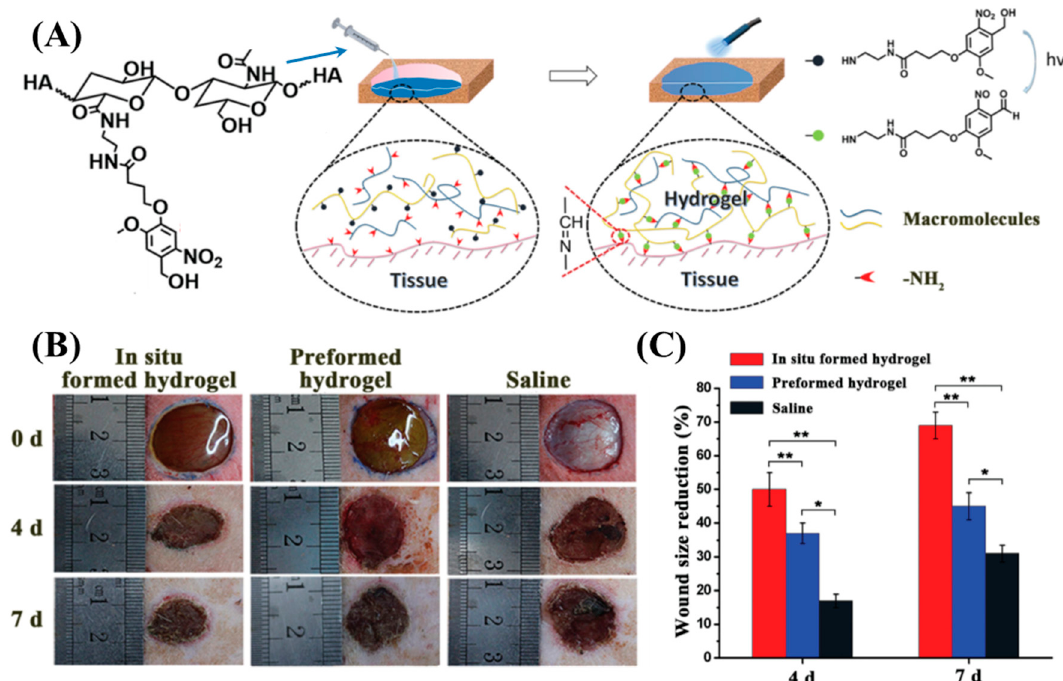
Figure 5. ( A ) Schematic representation of the phototriggered-iminecrosslinking (PIC) and adhesion mechanism of HA-oNB. ( B ) Photographs of subcutaneous wounds created on the backs of rats at treated with HA-oNB and controls. ( C ) Quantitative wound size reduction comparison between the three groups, indicating superior wound healing performance by in situ formed HA-oNB hydrogel [91]. Copyright 2016, reproduced with permission from WILEY-VCH Verlag GmbH & Co. KGaA, Weinheim.